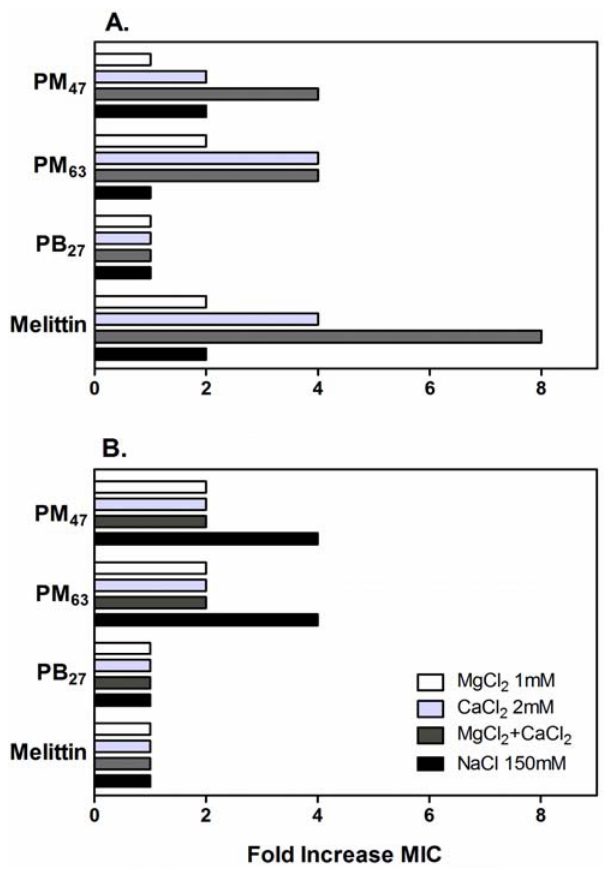
Figure 5. Influence of physiological salts on the antibacterial activity of PMAs and melittin against E . coli (A) and S . aureus (B) . Initial MIC values against E . coli or S . aureus —PM : 63 or 125 µg/mL, PM : 16 or 125 µg/mL, PB : 16 or 16 µg/mL, 47 63 27 melittin: 13 or 6